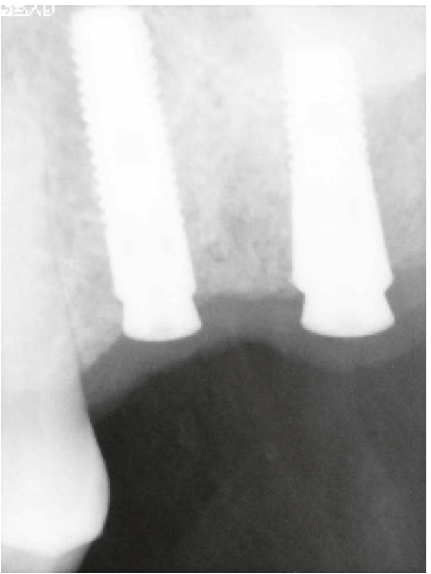
Figure 5: Astra ∗ implants (4.0 × 13, 5 × 11) replacing teeth 26 and 27.